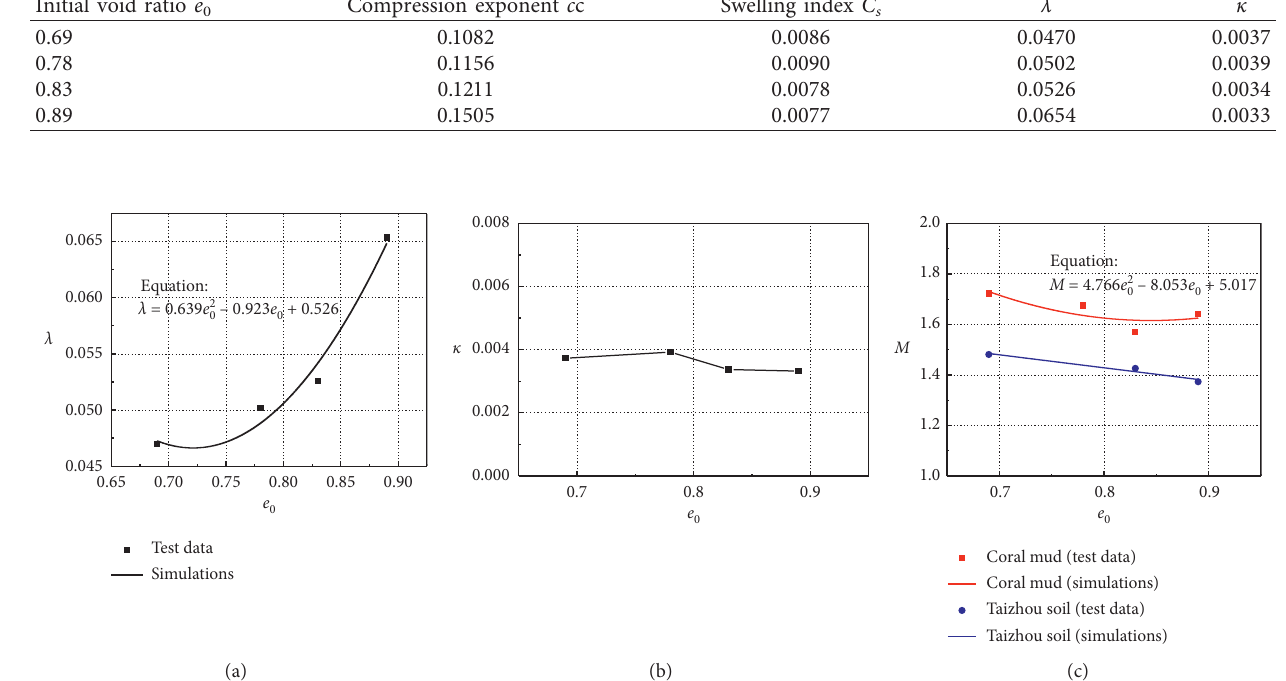
Figure 21: Relationship between the Cam-Clay model parameters and e between κ and e 0 of coral mud. (c) Relationship between M and e 0 .